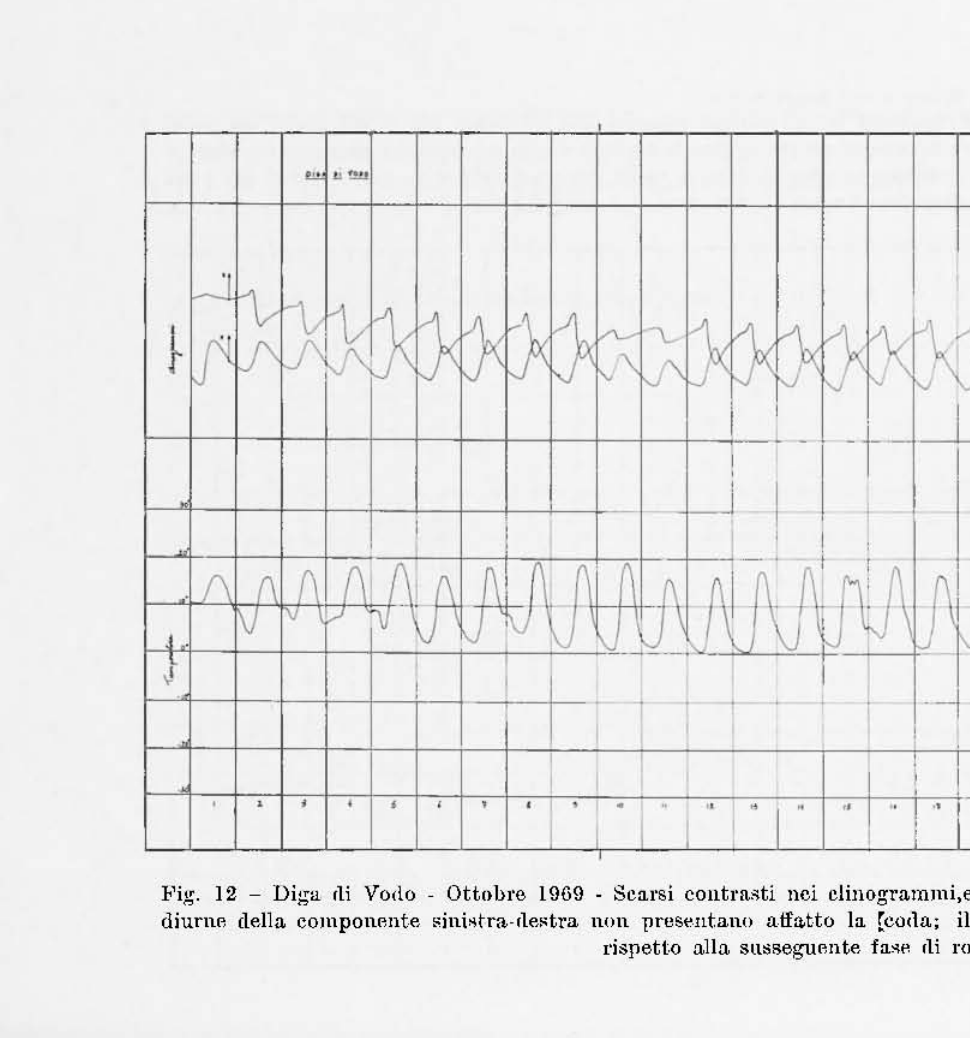
Fig. 12 - Diga (li Vodo _ Ottobre 1969 _ Scarsi cOlltra;;ti nei clillogramllli,esse!lrlo il diagramllla terlllico poco frastagliato. Le 011(11" diurne (Iella COlllponente Hilli~tra-(le~tra non prest'ntano utfa,uo la [colla; il picco di iniziale rotazione a de~tTa è alquanto piccolo